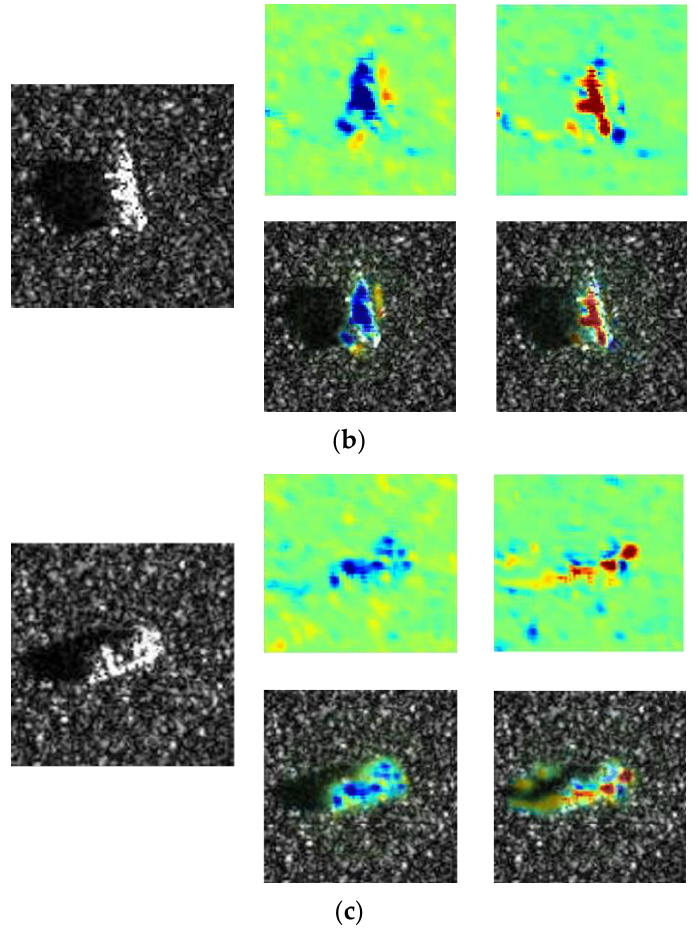
Figure 10. Heatmaps of true and predicted classes in SAR-BagNet for misclassification. ( a ) The true class is Class 0 (2S1) and the predict class is Class 9 (ZSU234). ( b ) The true class is Class 5 (BMP2) and the predict class is Class 6 (BTR70). ( c ) The true class is Class 6 (BTR70) and the predict class is Class 5